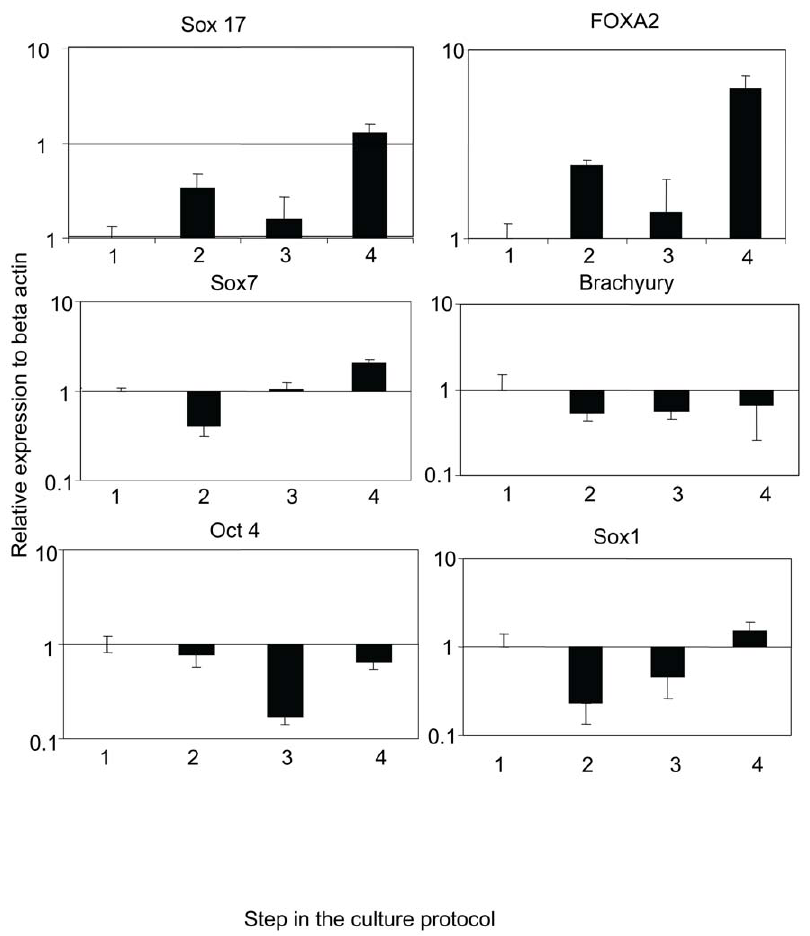
Figure 2. Quantitative PCR results of definitive endoderm markers (Sox 17 and FOXA2), mesoderm marker (brachyury), neuroectoderm marker (Sox 1), primitive endoderm marker (Sox 7), and pluripotency marker (Oct 4) in the cells cultured by the protocol. The expression of each gene is illustrated as expression of SYBR green (semi-log scale on Y axis) relative to its level in ES cells (1).